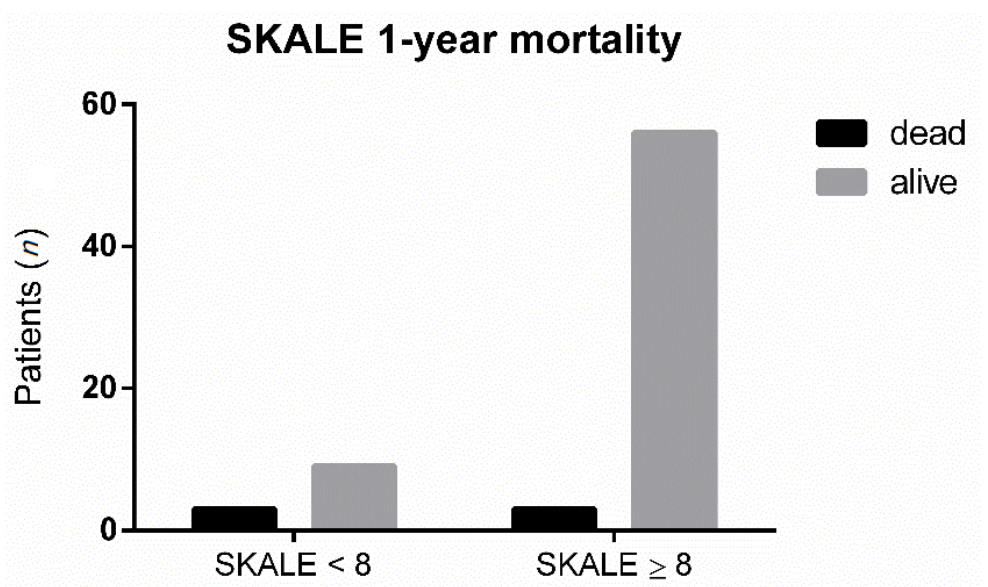
Figure 5. Comparison of SKALE <8 or SKALE ≥ 8 in terms of one-year mortality.